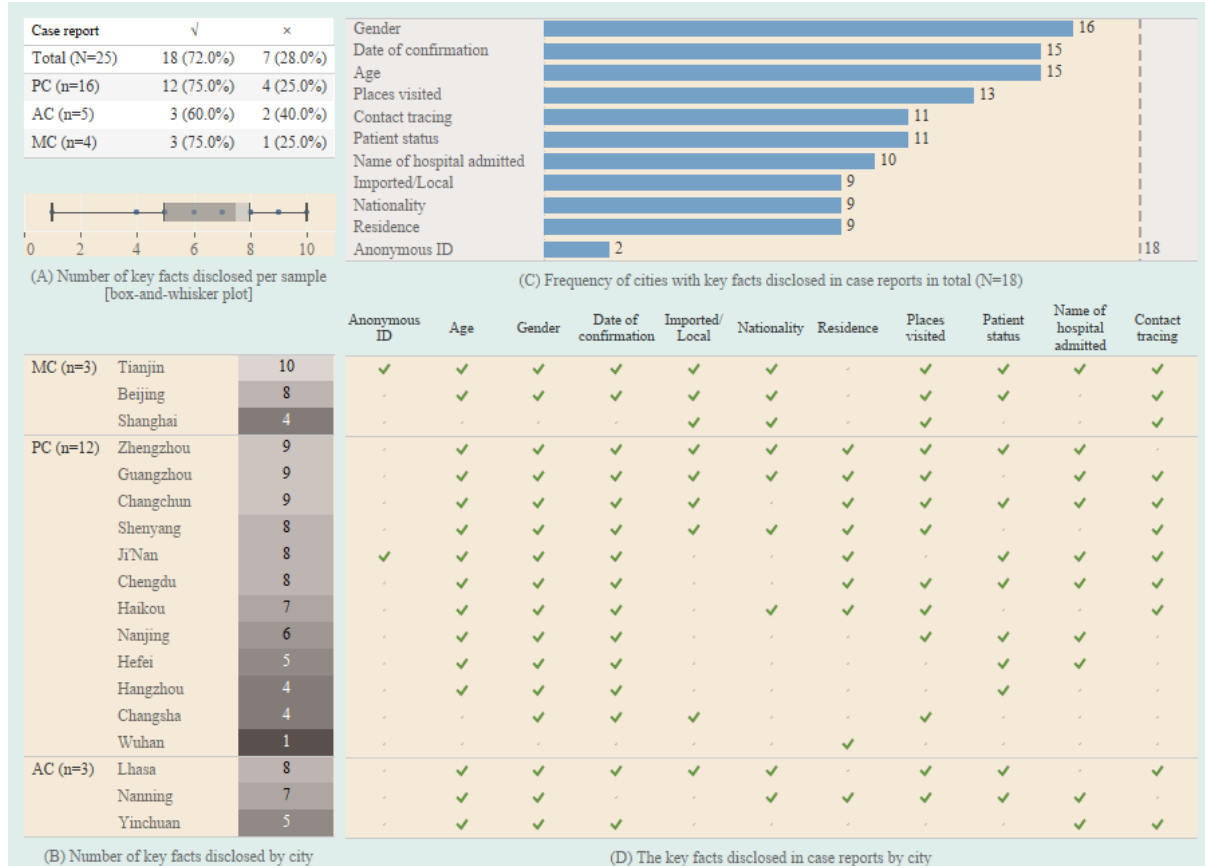
Figure 4. Key facts disclosed from the latest confirmed case reports as of March 18, 2020. (A) Number of key facts disclosed per sample; distribution was reported using a box-and-whisker plot. (B) Number of key facts disclosed by city; distribution was reported using a heatmap. (C) Frequency of cities with key facts disclosed in case reports in total (N=18). (D) The key facts disclosed in case reports by city. AC: autonomous region capital; MC: municipality directly administered by the central government; PC: provincial